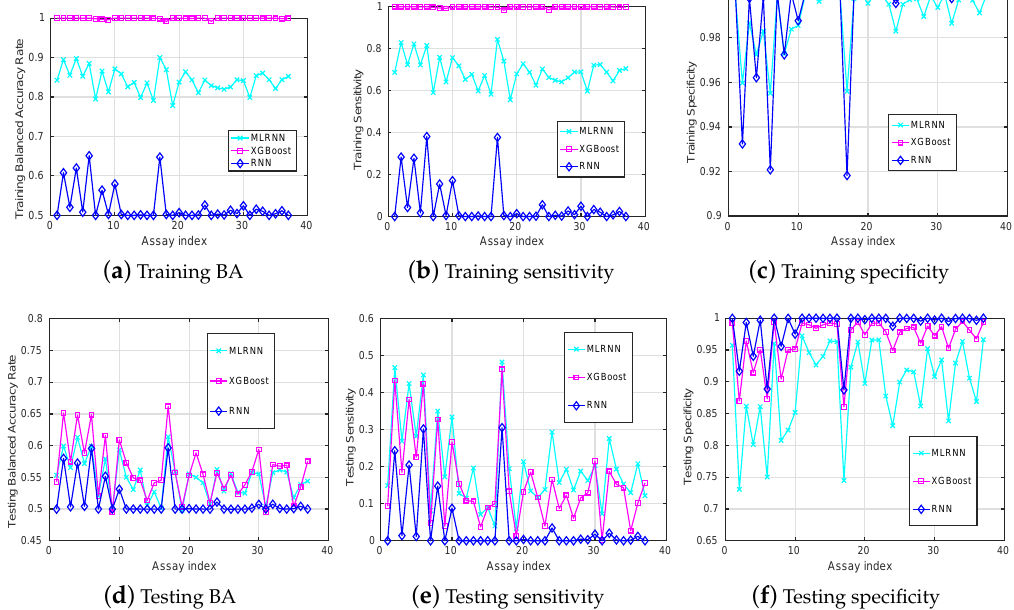
Figure 1. Training ( a – c ) and testing ( d – f ) mean-value results ( y -axis) versus different assays ( x -axis) when the MLRNN, XGBoost, RNN are used for